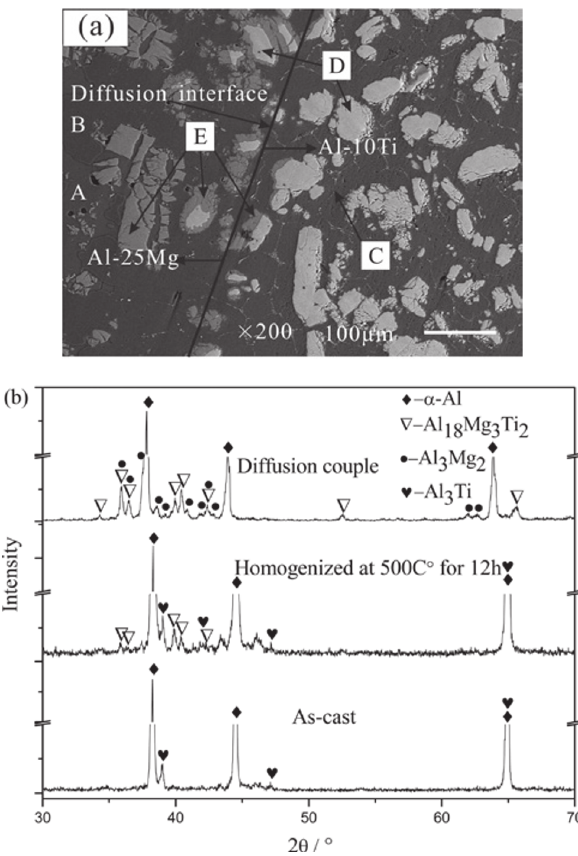
Fig. 4: (a) Microstructure of (Al-25wt.%Mg)/(Al-10wt.%Ti) diffusion couple annealed at 500 °C for 12 h and (b) XRD patterns of the couple and alloy